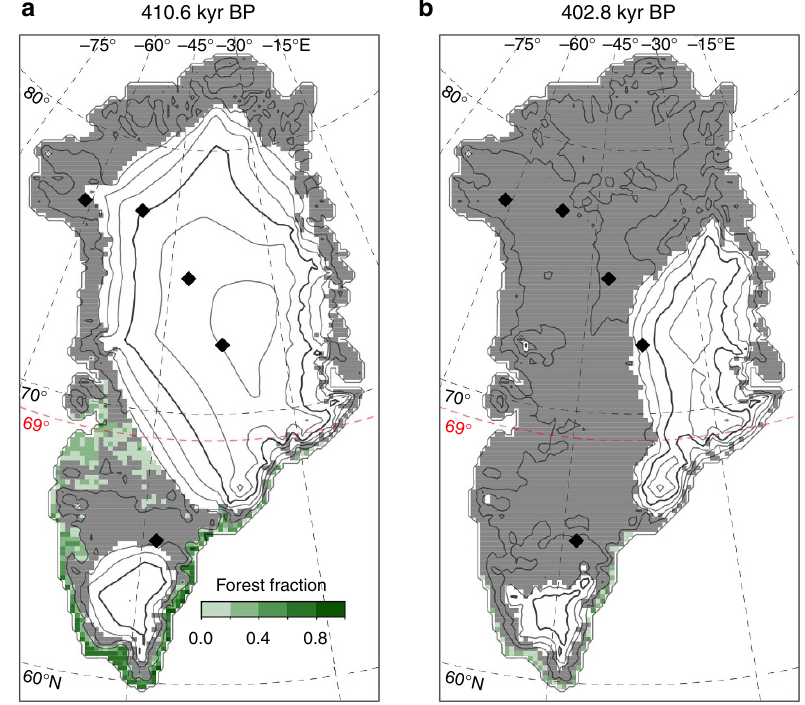
Figure 3 | Transient change. Simulated Greenland ice sheet configuration for the most likely simulation at the time of peak regional summer warming ( a ) and the minimum ice-sheet volume ( b ). Green shading indicates the estimated boreal forest cover for each case. Black diamonds show the following ice core locations from North to South: Camp Century, NEEM, NGRIP, GRIP and DYE-3. The 69 (cid:2) N parallel is highlighted (red dashed line) as the boundary demarcating the southern bedrock terranes.